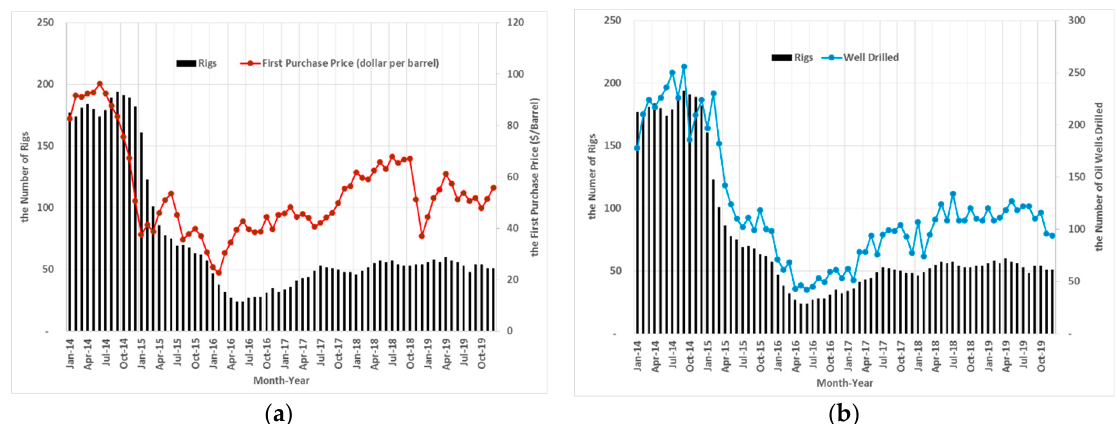
Figure 2. Active oil wells and the number of rigs in operation: ( a ) the number of rigs and the first purchasing price and ( b ) the number of rigs and the number of wells drilled in the Williston Basin [39].